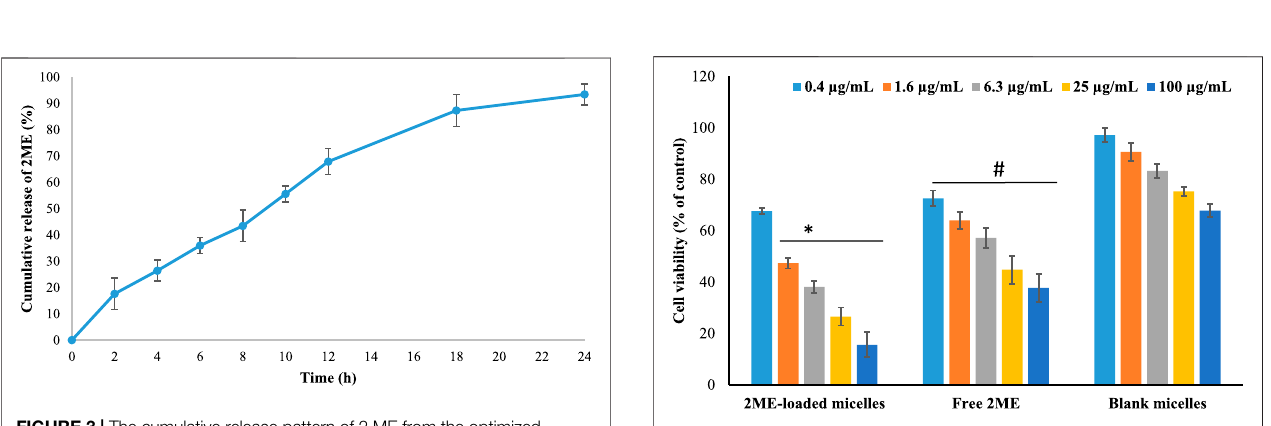
FIGURE 4 | Cell viability of the cells treated with 2 ME-loaded mixed micelles,freedrug(2 ME)and blankmicelleswere presented.Controlgroupis 100% cell viability. Values are expressed as mean ± SD ( n (cid:2) 3). * represents signi fi cantdifferencebetween 2ME-loadedmixedmicelles( p < 0.05) vs. blank micelles and free 2 ME [except for 0.4 μ g/ml for ( p > 0.05). # represents signi fi cant difference between free 2 ME vs. blank micelles ( p <